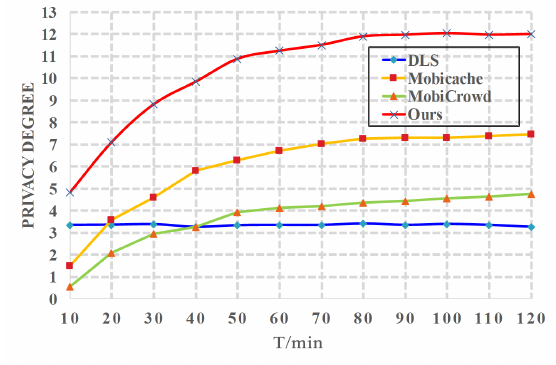
Figure 7. Privacy Degree vs. t .